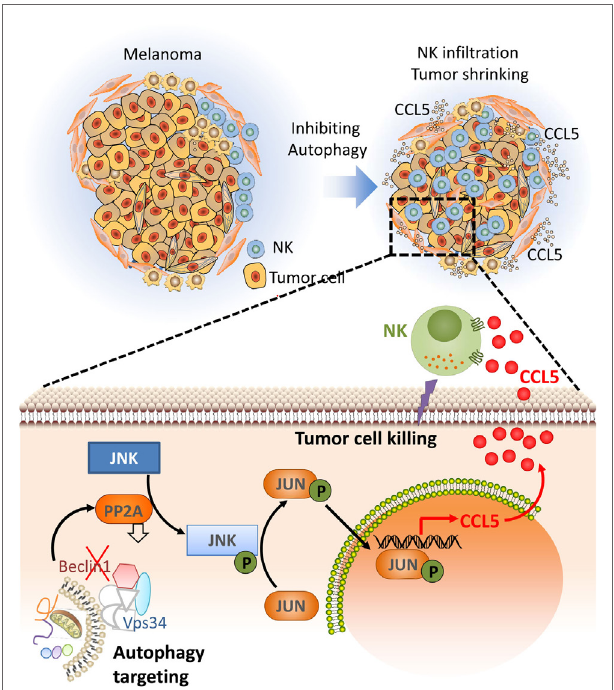
FiGURe 2 | Targeting autophagy leads to tumor regression by inducing the infiltration of natural killer (NK) cells into the tumor bed. Targeting autophagy in tumor cells induces the expression of CCL5 cytokine. Through paracrine mechanism, CCL5 binds its receptors expressed on the surface of NK cells and induces the recruitment of functional NK cells to the tumor bed. Functional NK cells recruited to the tumor kill cancer cells leading to tumor regression. The lower part describes the molecular mechanism underlying the expression of the chemotactic cytokine CCL5. Briefly, targeting Beclin1 leads to a decrease in the activity of the protein phosphatase 2A by a mechanism not yet understood. Such a decrease enhances the phosphorylation of JNK that subsequently phosphorylates c-JUN. Phosphorylated c-JUN binds to the promoter of Ccl5 and induces its transcription. CCL5 released by Beclin1- defective tumor cells binds to CCL5 receptor on the surface of NK cells, and induces their infiltration. Functional NK cells recruited to the tumor site kill cancer cells and thereby reduce the tumor